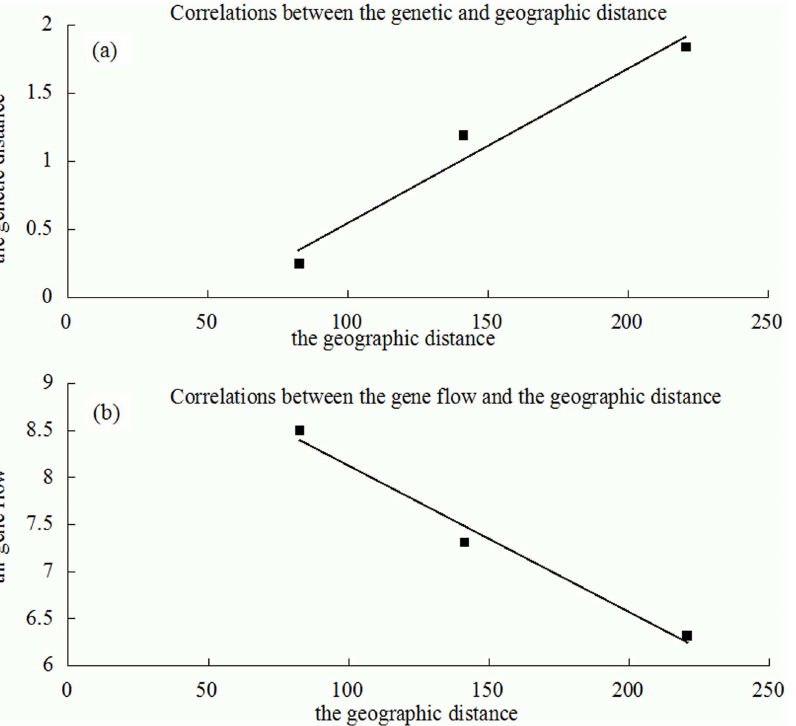
Figure 2. The correlations between the geographic distance and the genetic distance (a), and gene flow (b).